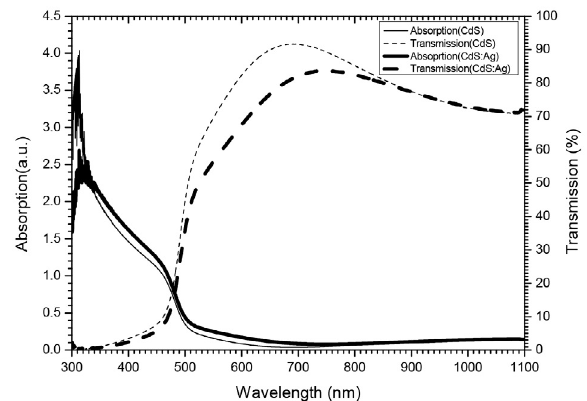
Figure 1. Absorption and transmission responses for CdS and sil- ver coated CdS thin films.